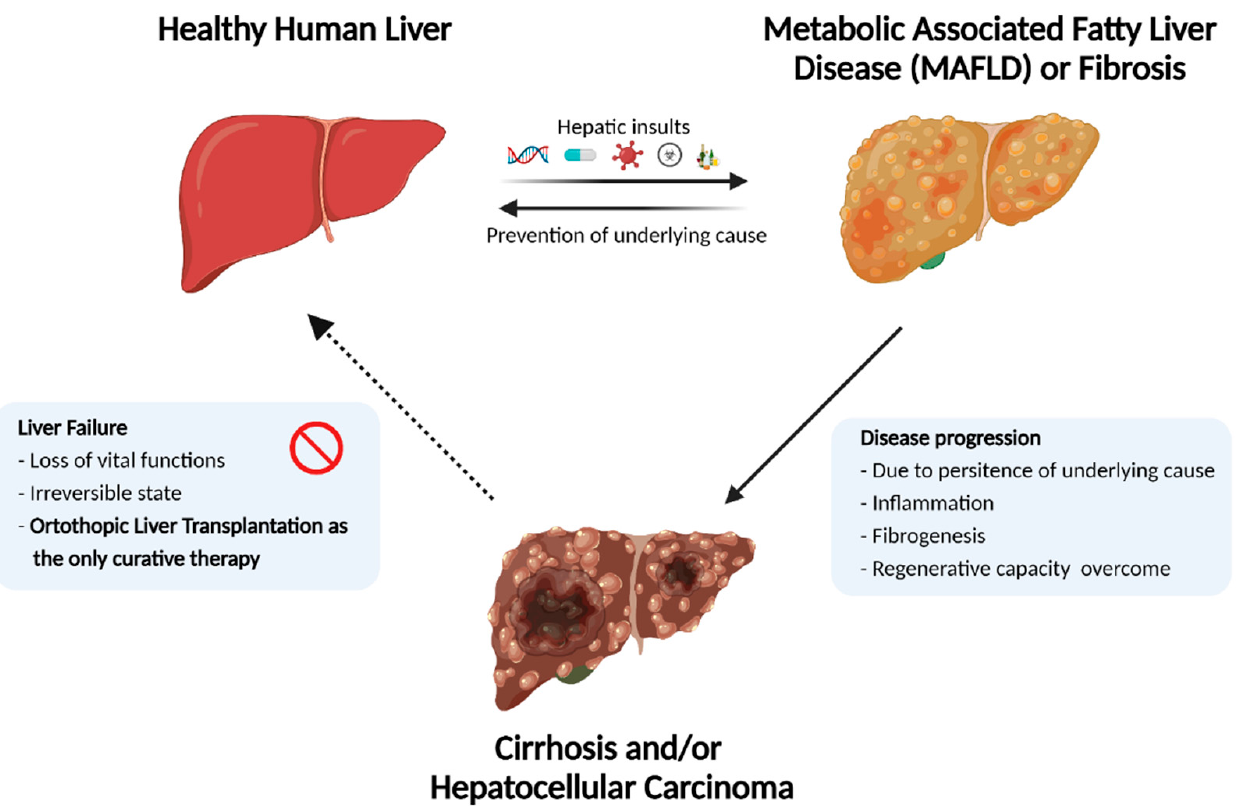
Figure 1. Progression to End-Stage Liver Disease. Inborn metabolic disorders or hepatic insults such as drug chronic viral infection, exposure to toxic chemicals, alcohol abuse, and fatty diet may result in a fibrotic and/or inflammatory liver. Persistence of hepatic insults may overcome the inherent regenerative capacity of the liver, resulting in liver failure. As this state is irreversible, the only curative therapy is orthotopic liver transplantation.